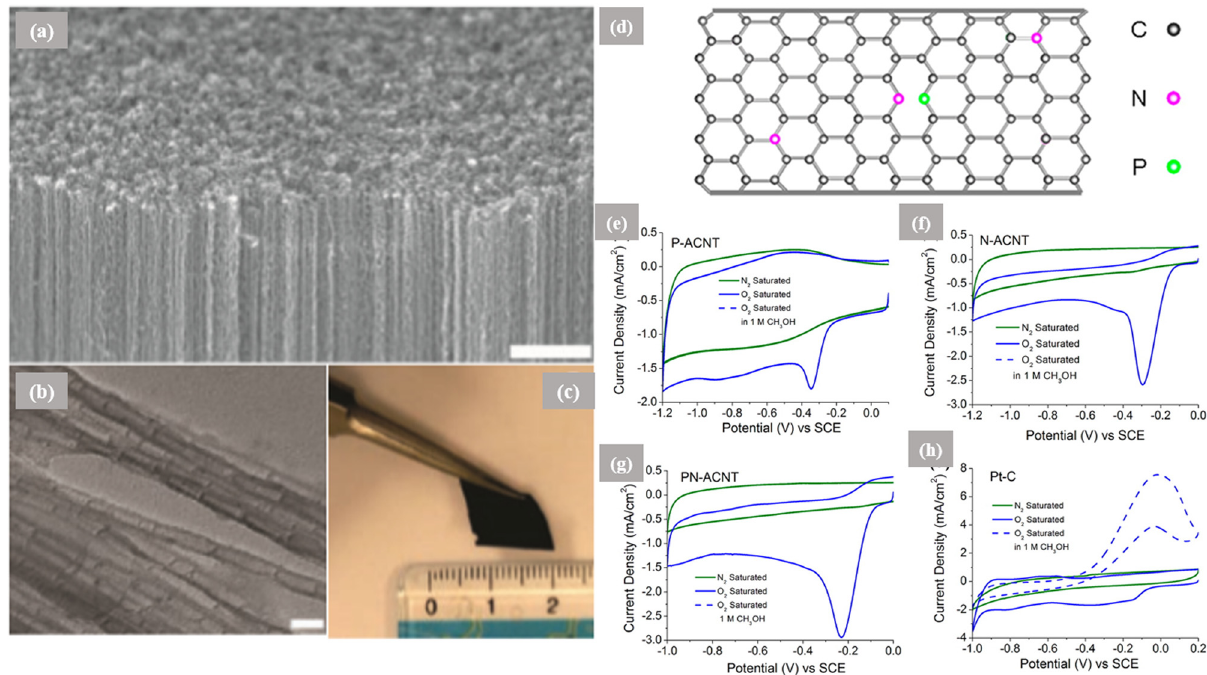
Figure 13: ( a ) SEM images of the as - synthesized VACNTs on a substrate. ( b ) TEM image of the puri fi ed N - VACNTs. ( c ) The photograph of the N - VACNT array [ 100 ] . Copyright 2012, Wiley. ( d ) Schematic of the possible P – N codoped VACNT structure. The cyclic voltammograms for the ORR at the ( e ) P - VACNT/GC electrode, ( f ) N - VACNT/GC electrode, ( g ) PN - VACNT/GC electrode, and ( h ) Pt – C/GC electrode in an aqueous solution of 0.1 M KOH saturated by nitrogen or oxygen gas or an oxygen - saturated 0.1 M solution of KOH upon addition of CH 3 OH ( 1 M ) [ 101 ] . Copyright 2012, American Chemical